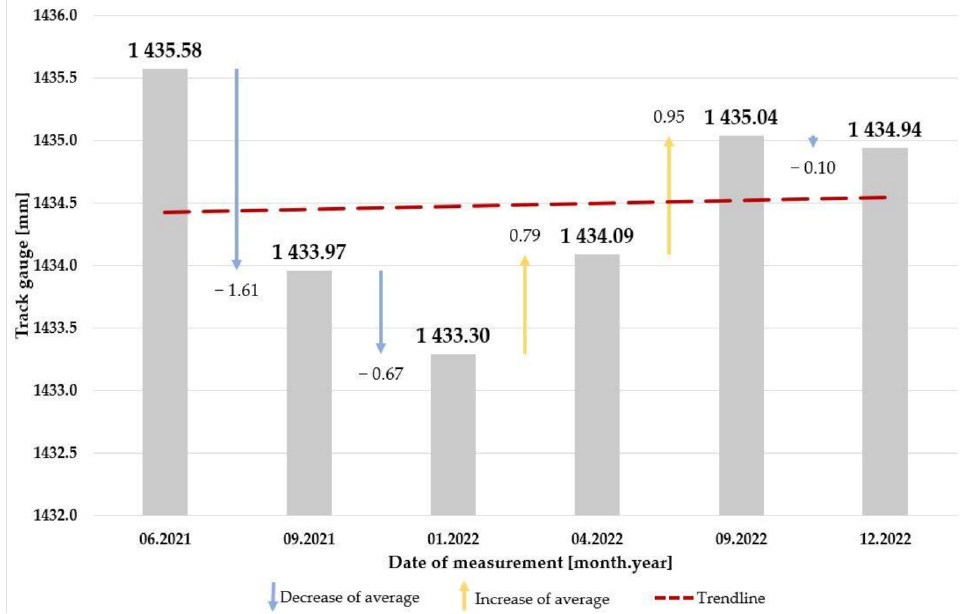
Figure 16. The change of average values of the track gauge in Section #4.